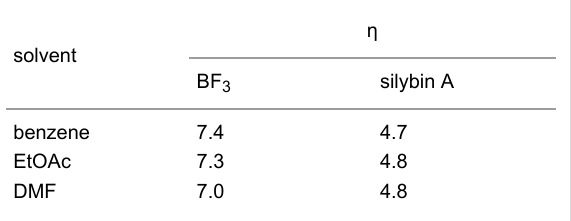
Table 2: Chemical hardness ( η , eV) of BF 3 and silybin A ( 1a ), in three different solvents (obtained at the IEFPCM B3P86/6-31+G(d,p) level of theory).